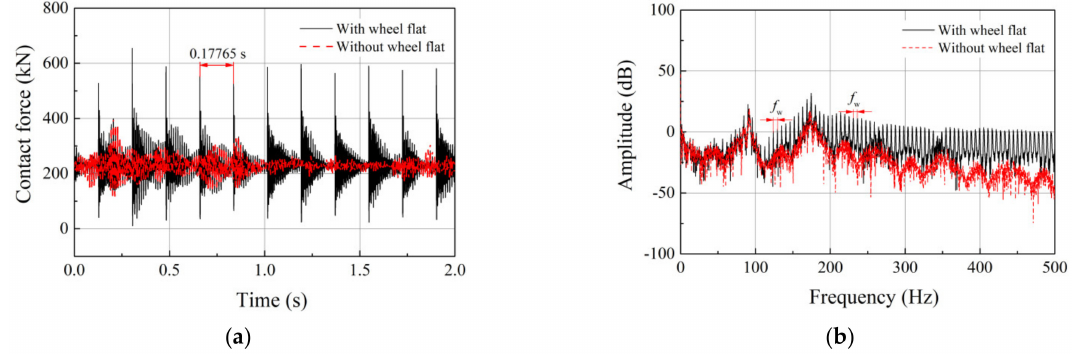
Figure 5. Wheel − rail contact forces: ( a ) time histories and ( b ) frequency spectrum.